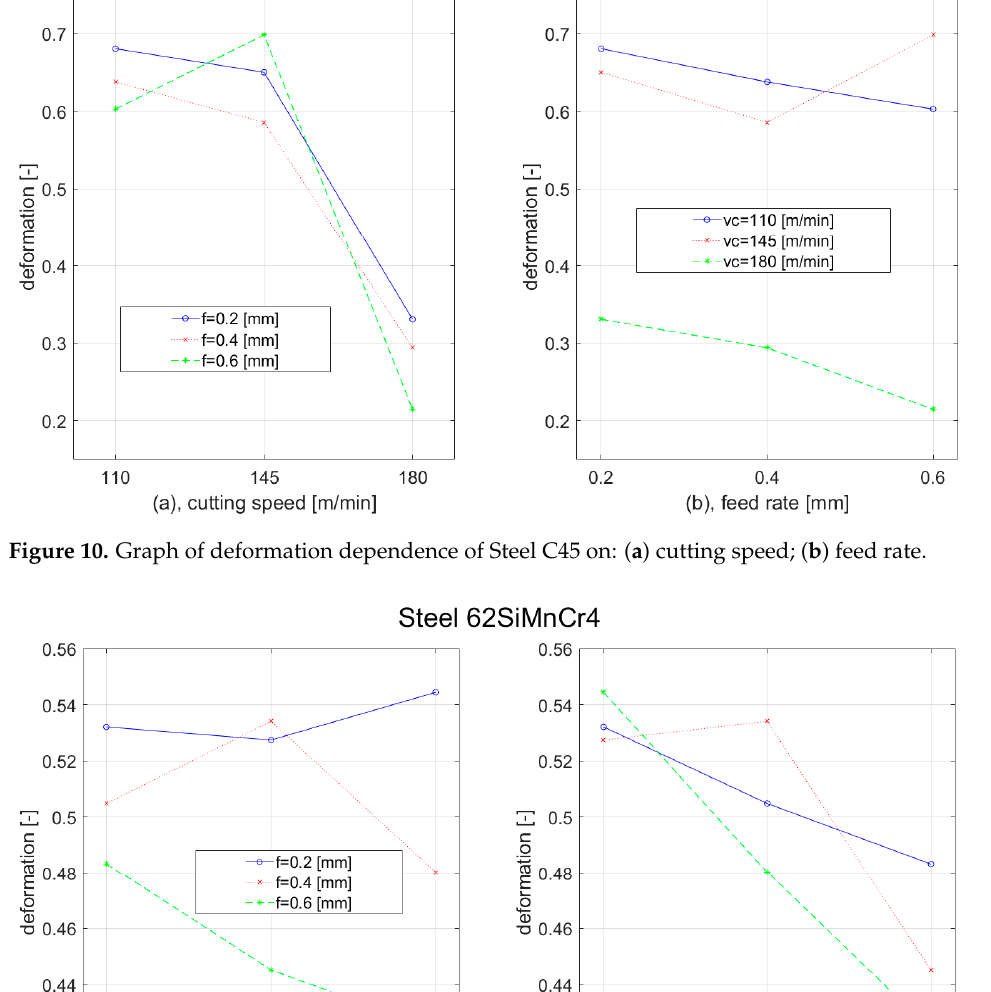
Figure 10. Graph of deformation dependence of Steel C45 on: ( a ) cutting speed; ( b ) feed rate.